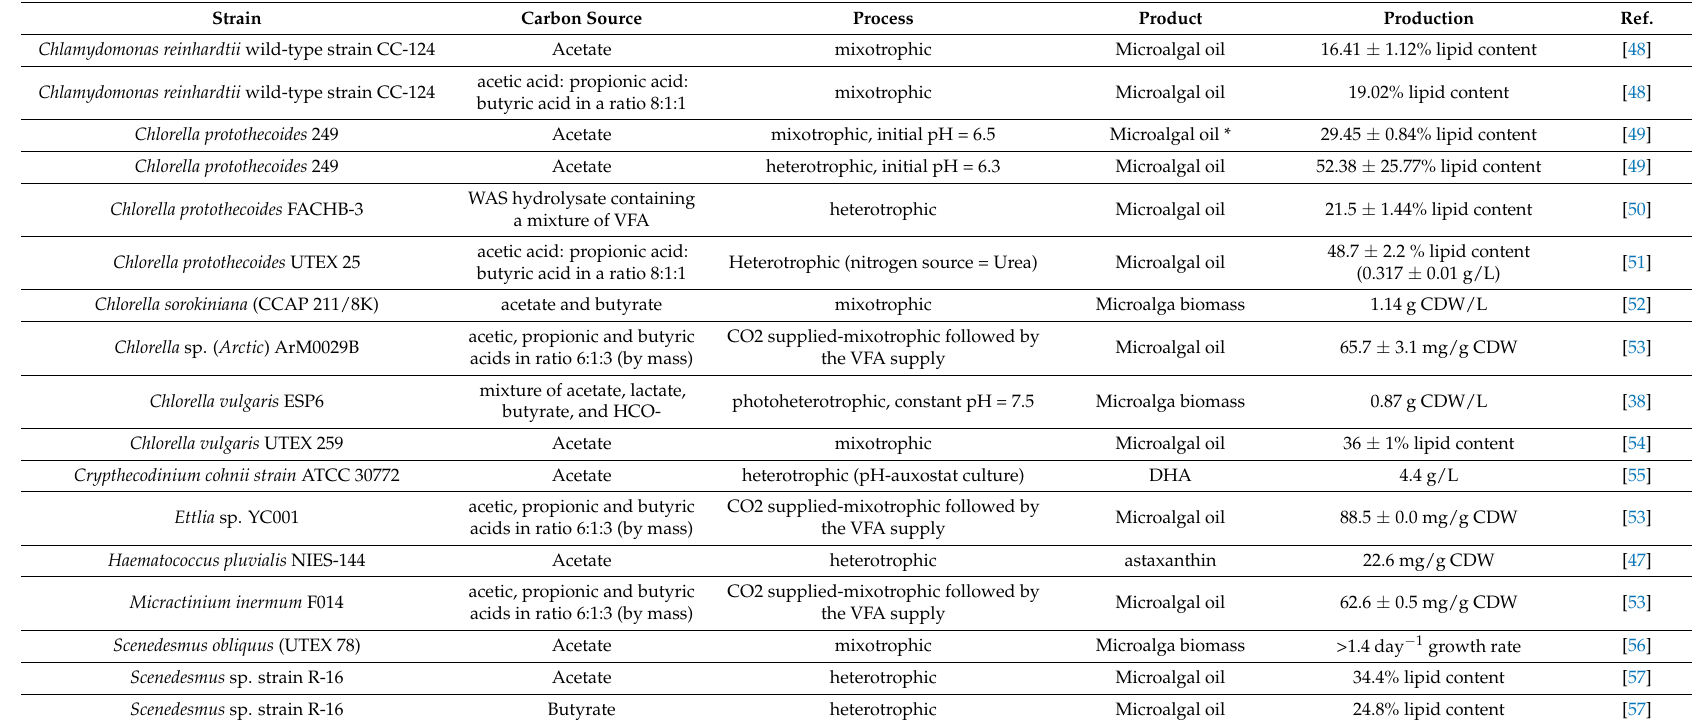
Table 2. Microalgal strains that utilize VFA as carbon